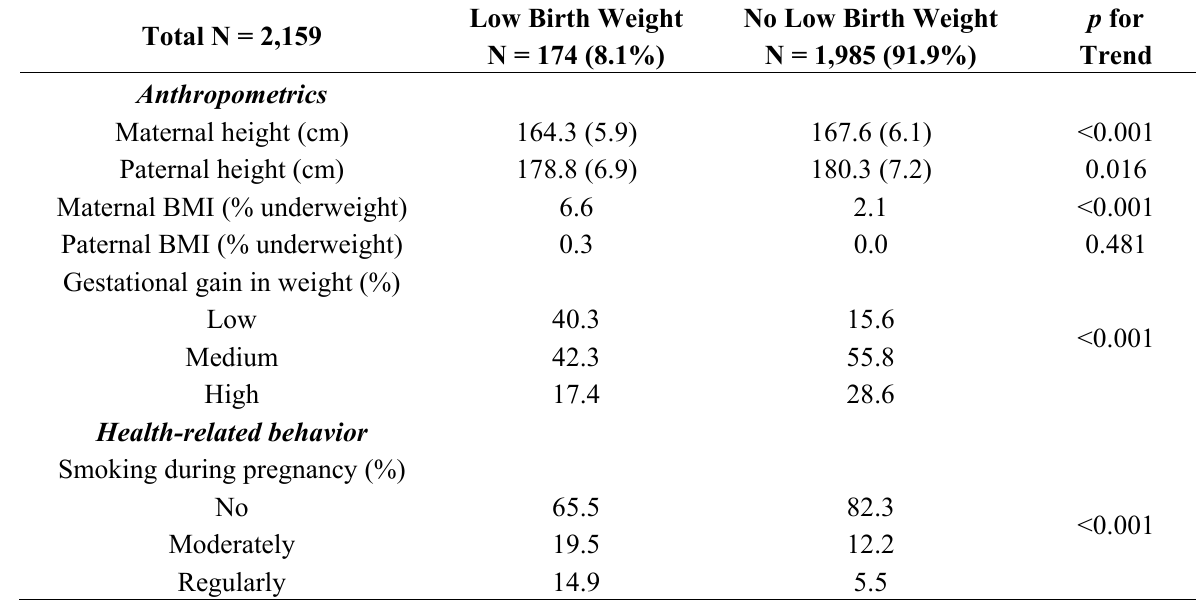
Table 2. Relation between low birth weight and potential